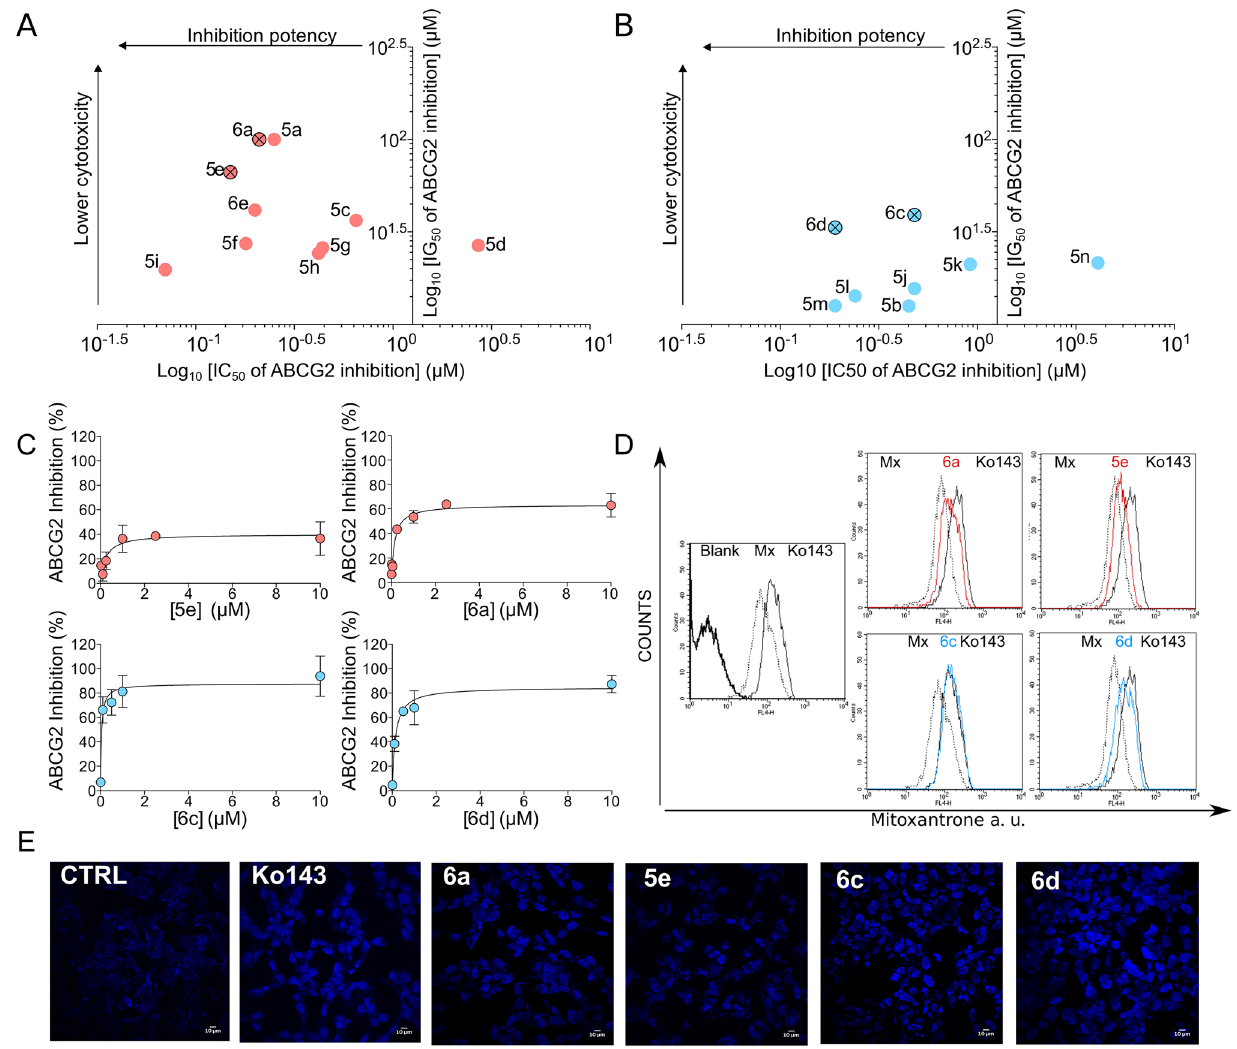
Figure 2. Inhibition potency and cytotoxicity of compounds with the best therapeutic ratios. ( A ) Partial inhibitors (red) and ( B ) complete inhibitors (blue). ( C ) Representative IC 50 curves of the partial and complete inhibitors. ( D ) Representative flow cytometry histograms of mitoxantrone accumulation in HEK293- ABCG2 cells. Overlay of histograms obtained by compounds at 10 µM mitoxantrone and Ko143. ( E ) Representative confocal microscopy images of Hoechst 33342 (1 µM) accumulation in HEK293- ABCG2 cells, using the program ImageJ2 (URL: https ://image j.net/Fiji). Effect produced by compounds at 10 µM compared to the reference inhibitor Ko143 at 0.5